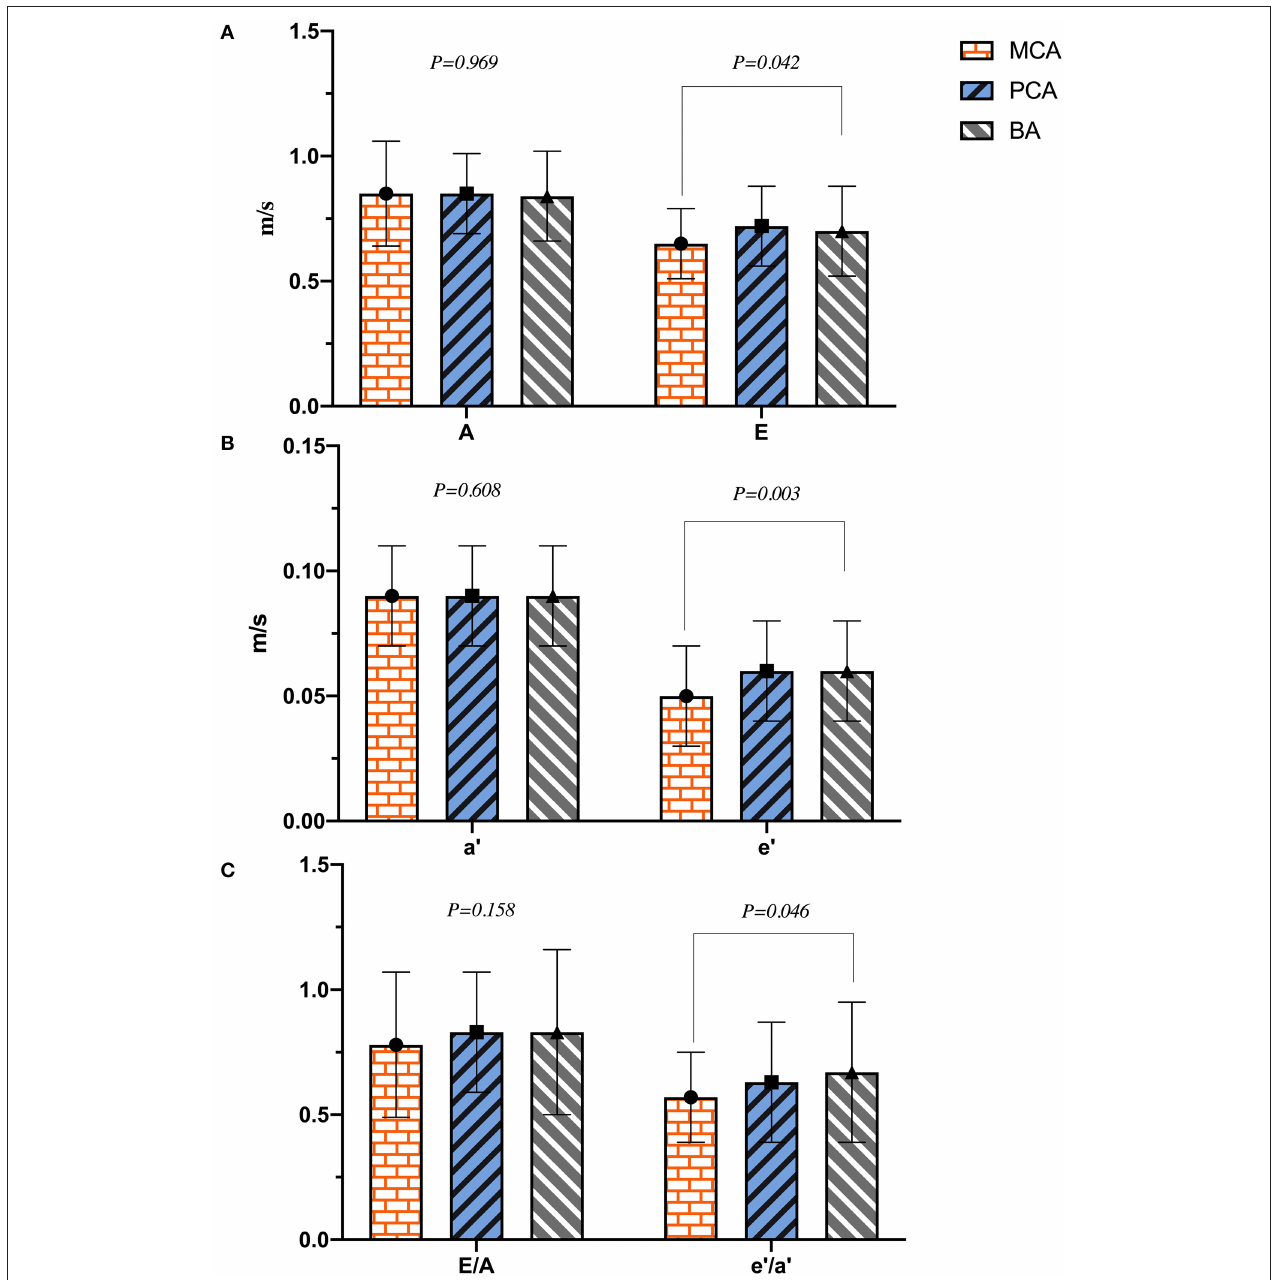
FIGURE 4 | The plot of (A–C) indicated the difference of left ventricular diastolic function in different cerebral artery groups.